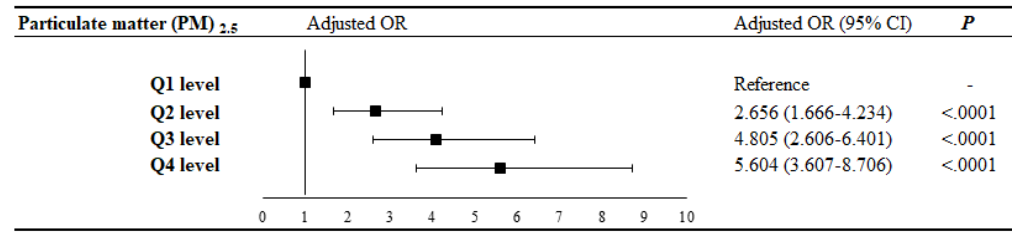
Figure 3. Odds ratio of AR associated with the cumulative PM 2.5 exposure level.